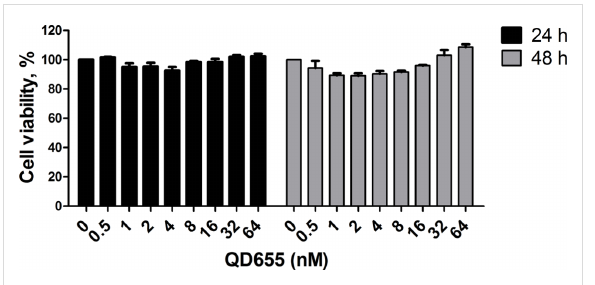
Figure 1: The concentration-dependent effect of QDs on the viability of MSCs. Viability was measured by a colorimetric assay (CCK-8) after incubation with QDs at 0.5–64 nM for 24 and 48